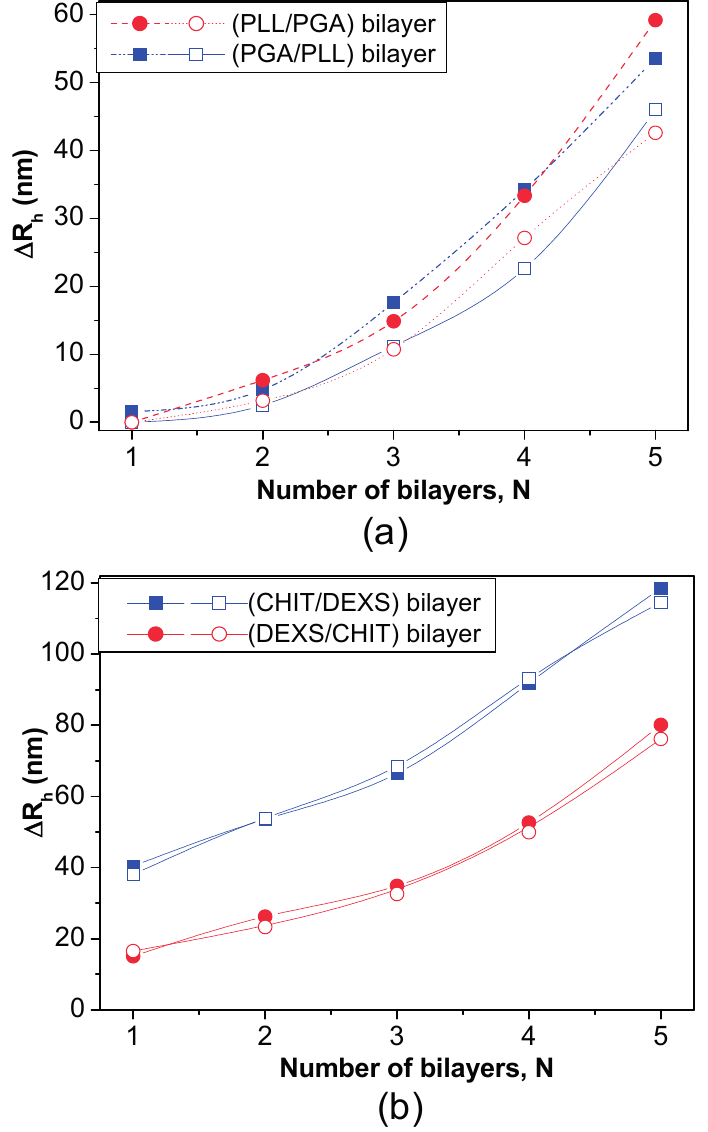
Figure 12. Bilayer thickness for different polyelectrolyte layers at 20 °C: ( a ) NG/(PLL/PGA) and ( b ) NG/(CHIT/DEXS). The solid and empty symbols correspond to values obtained before and after the heating-cooling cycle is applied,